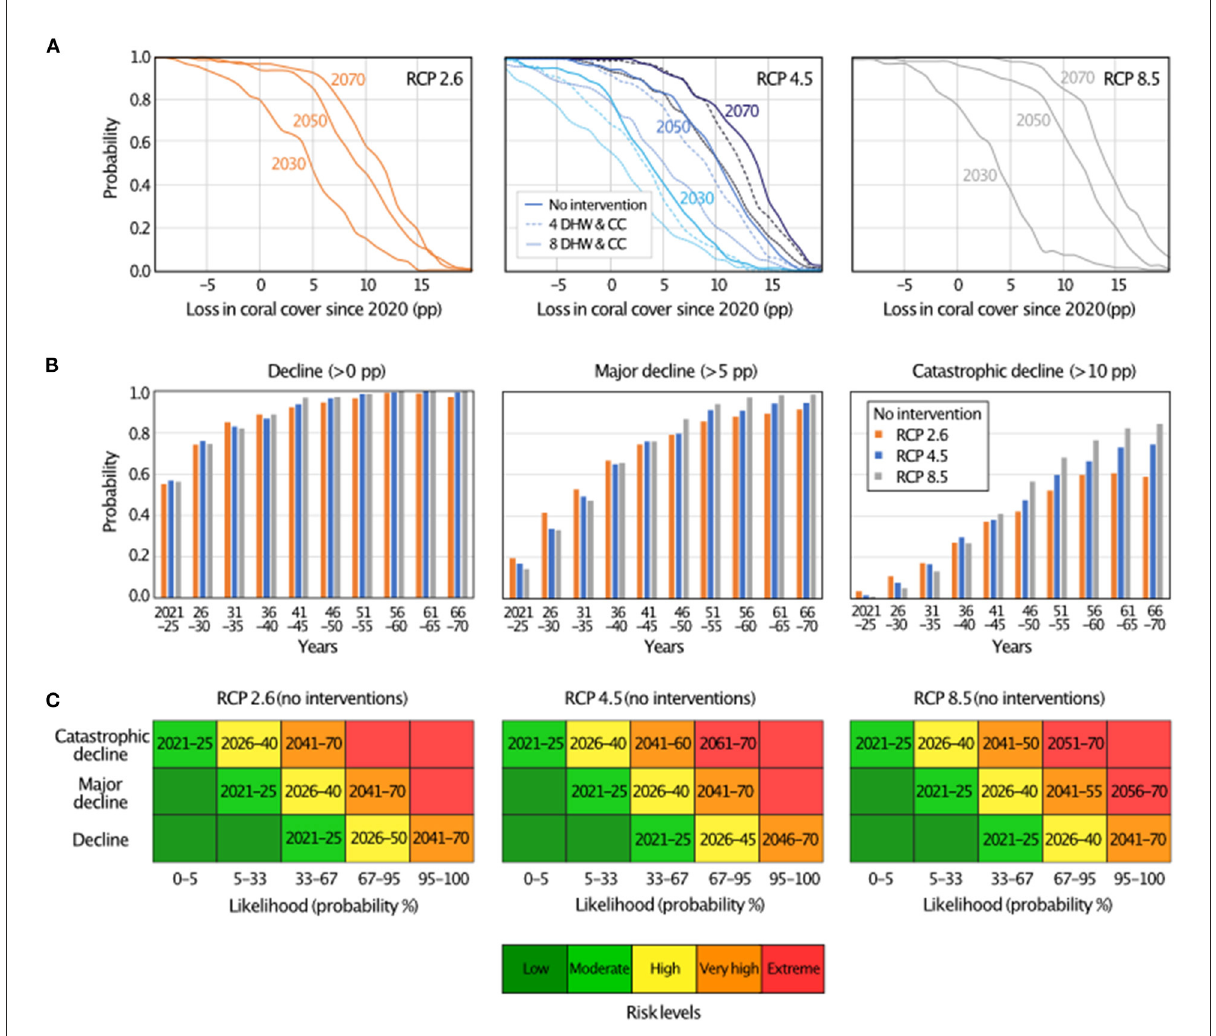
FIGURE3 Comparisons of risk to coral cover (percentage of available reef habitat averaged over all reefs on the GBR) for RCP 2.6, RCP 4.5, and RCP 8.5 (scenarios 1–3, respectively) based on 100-run ensembles. (A) Probability of coral losses relative to 2020 in years 2030, 2050, and 2070. Dashed lines (RCP 4.5 only) include interventions in the form of CoTS control on the central GBR and two levels of SRM (4 DHW for scenario 8 and 8 DHW for scenario 11) applied across the GBR. (B) Probability of a net decline ( > 0 pp, left), a major decline ( > 5 pp, center), and a catastrophic decline ( > 10 pp, right). (C) Risk matrices indicating the likelihood (probability) of each level of coral cover impact (decline) over time measured in 5-year blocks over the period 2021–2070. The selected risk level descriptors (and colors) are only illustrative and can be modified to align with the objectives of any risk